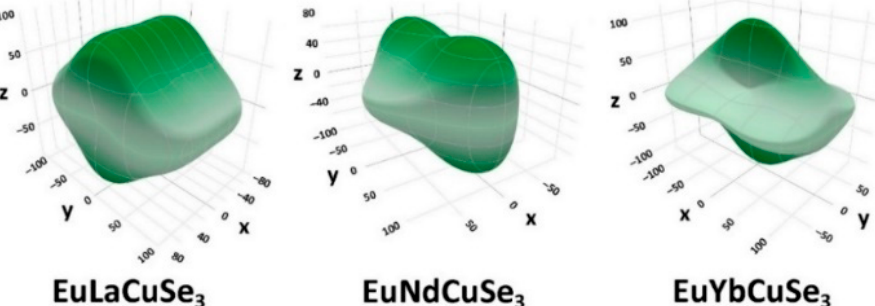
Figure 5. Dependence of the Young’s modulus (GPa) on the direction in the crystals of EuLnCuSe 3 (Ln = La, Nd, Yb).